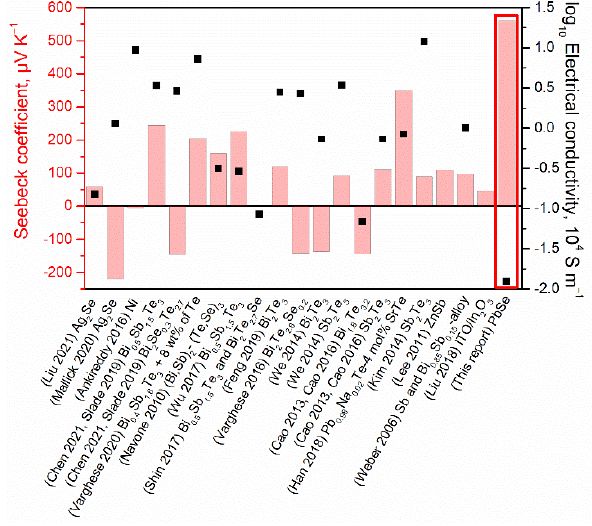
Figure 5. Comparison of the Seebeck coefficient and electrical conductivity for different reported thermoelectric thin films fabricated using the screen printing technique [1,16 – 30,35 –